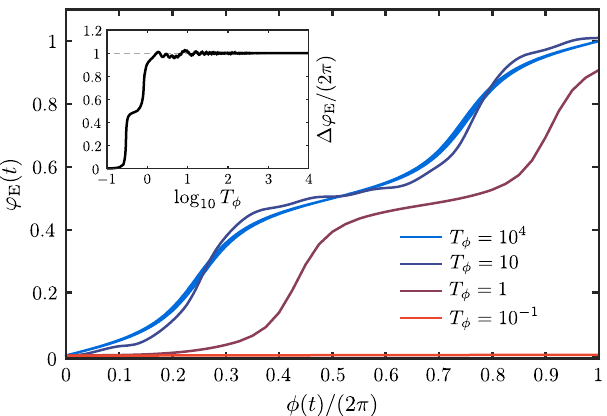
FIG. 5. Dynamical measurement of the EGP φ the parameter ϕ ð t Þ / ð 2 π Þ ¼ t / T ϕ , completing a closed cycle in parameter space over the time period T ϕ . The system examined here is the Rice-Mele model in thermal equilibrium discussed in Sec. IV. Inset: Total EGP difference ½ 1 / ð 2 π Þ(cid:2) Δ φ over one cycle, as a function of T ϕ